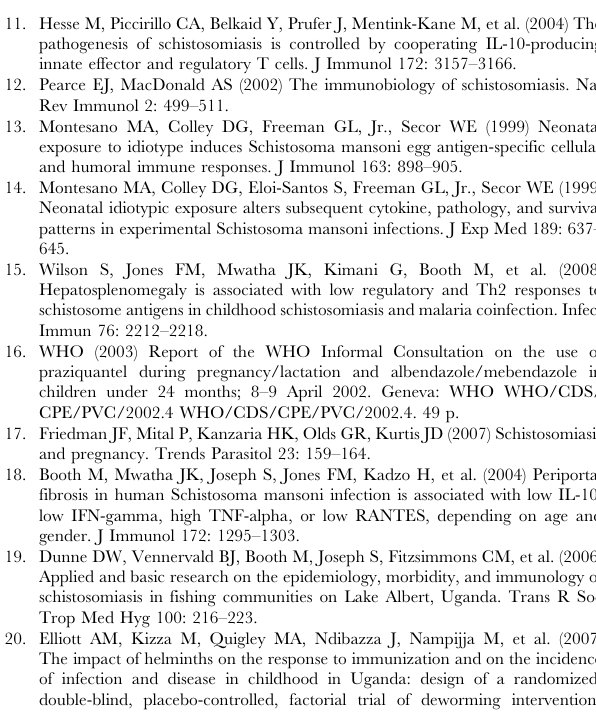
Figure S1 Cytokine levels in supernatants of unstimulated cultures. Figure S2 Example of the gating strategy applied for regulatory T cell. The gate for A) Lymphocytes, B) selection to eliminate